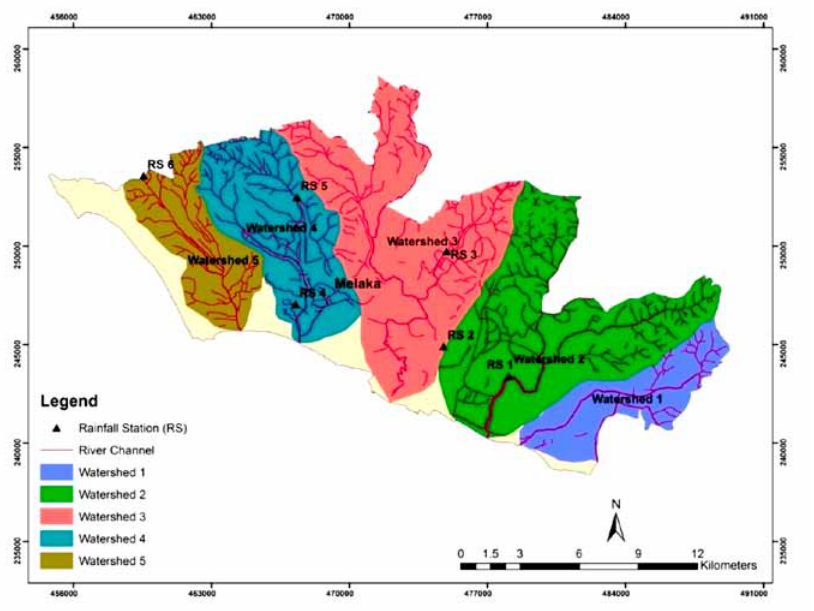
Fig. 2. Watersheds and river channel network at Melaka Tengah